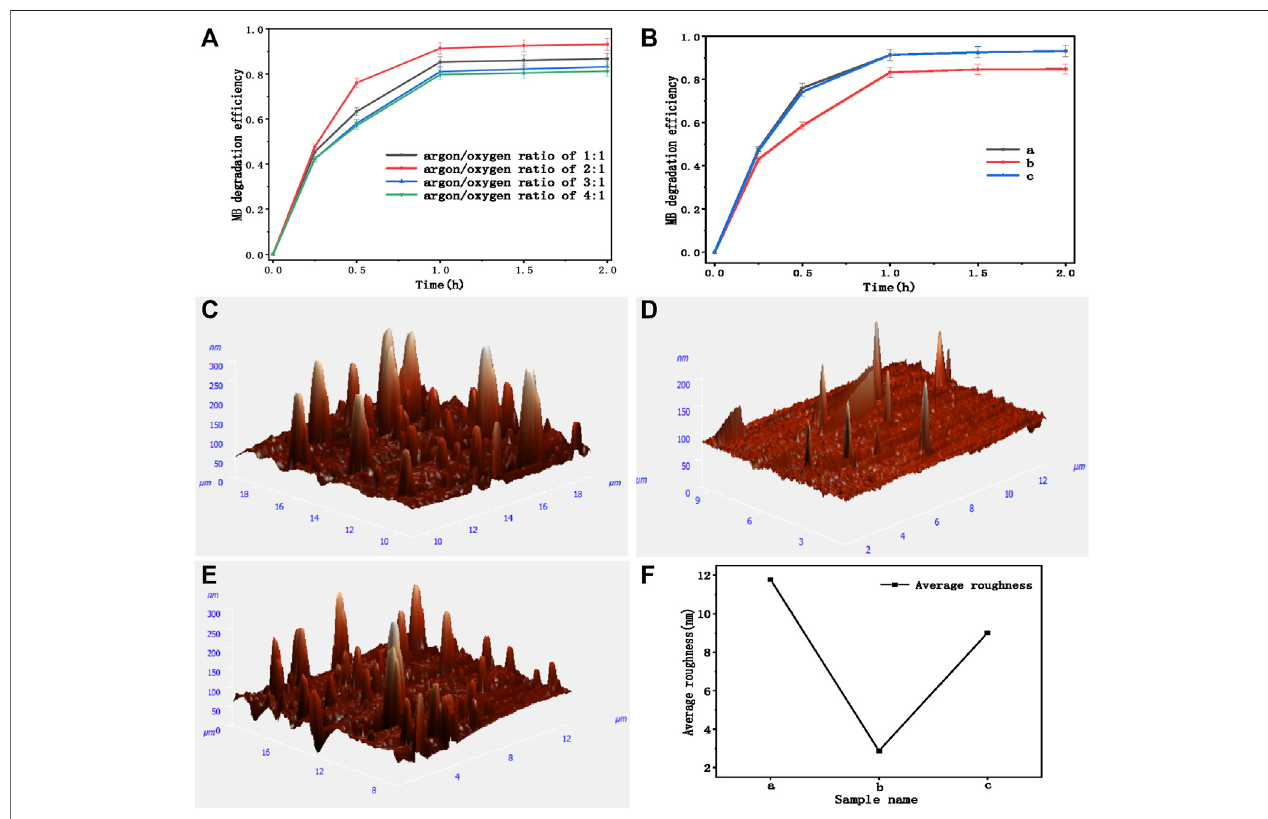
FIGURE 2 | Photocatalytic degradation of methylene blue by multifunctional fi lms (A) of TiO 2 layer with different argon oxygen ratios and (B) with different layer thicknesses. (C – F) AFM images and average roughness of samples a, b, and c (different samples divided by sputtering time; a = 1800sWO 3 ,3sMo,4sNiCr,3600sTiO 2 ; b = 1800sWO 3 ,5sMo,4s,NiCr,1800sTiO 2 ; c = 1800sWO 3 ,5sMo,4sNiCr,3600sTiO 2 ; d = 1800sWO 3 ,45sMo,4sNiCr,3600sTiO 2 ; e = 1800sWO 3 ,70sMo,4sNiCr,3600sTiO 2 , f = 1800sWO 3 ,95sMo,4sNiCr,3600sTiO 2